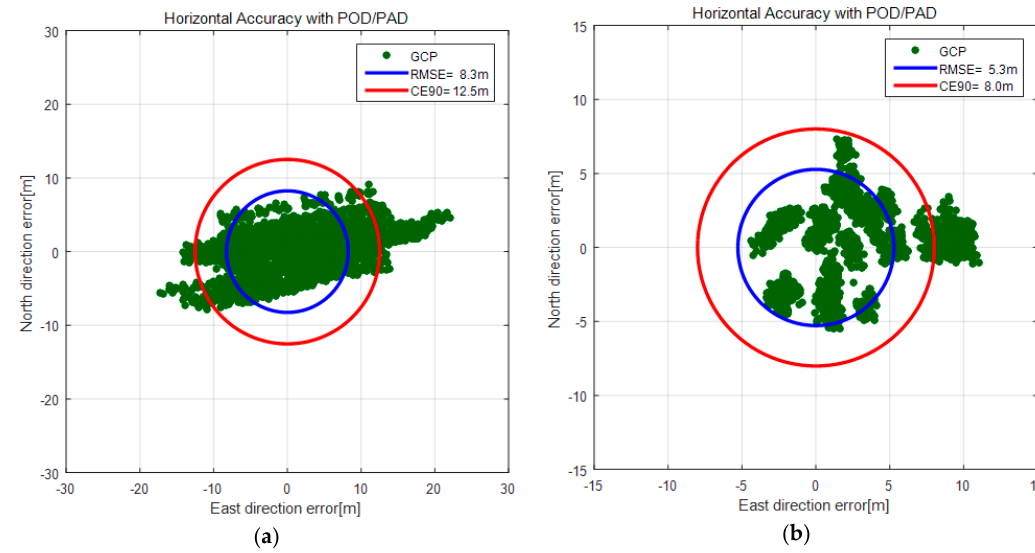
Figure 8. Horizontal accuracy before ( a ) and after the CCD alignment calibration ( b ).